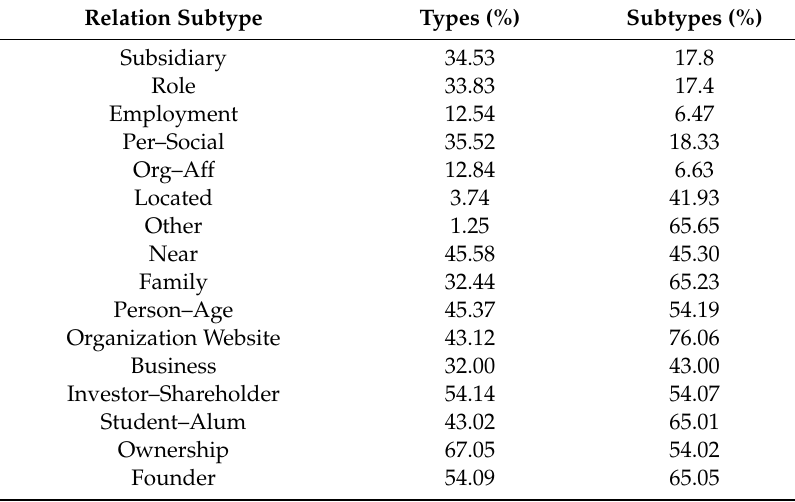
Table 13. Relation subtype statistics for the initial